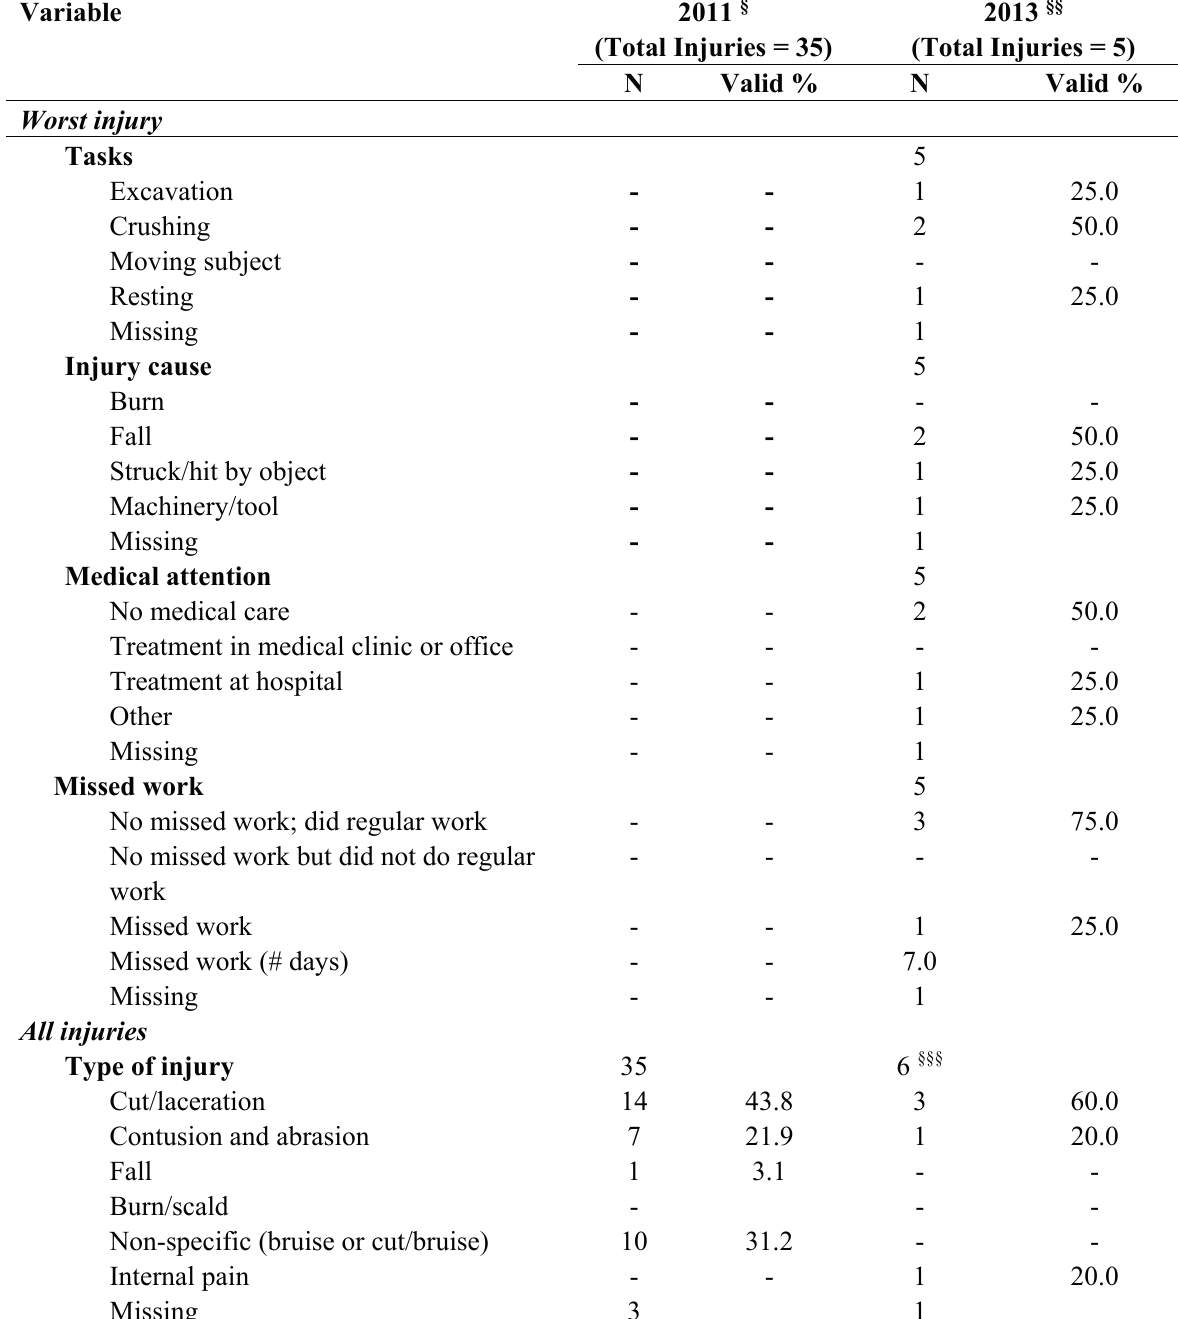
Table 3. Summary of information on individual ever-miners’ injuries for 2011 (n = 86) and 2013 (n =